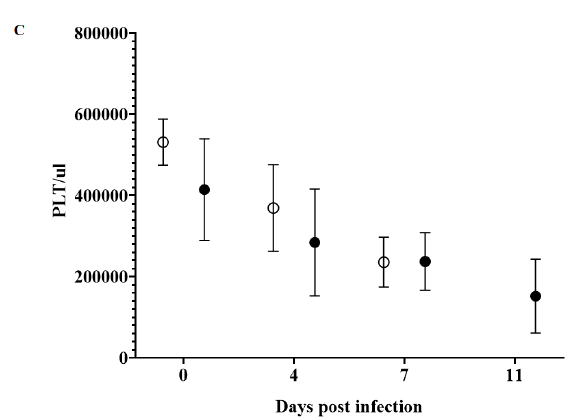
Figure 5. Concentration of circulating white blood cells ( A ), lymphocytes ( B ) and platelets ( C ) in animals IN infected with 10 5 TCID 50 of either E2 ∆ CCDC115v (filled symbols) or parental BICv (open symbols). Results represent the average and the standard deviation values of all animals in the group at the given time point. No significant differences were found between both groups of pigs at any time point using the statistical methodology described in Figures 3 and 4.